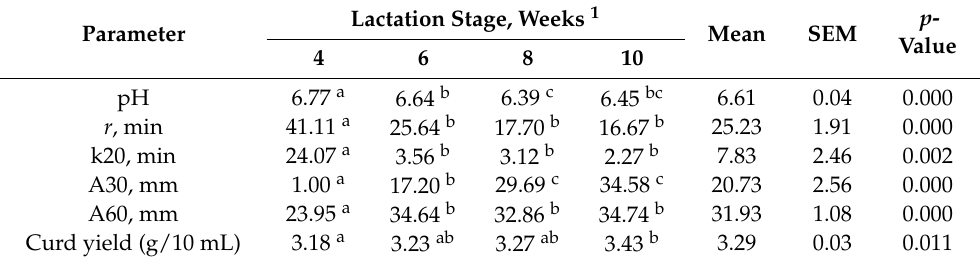
Table 6. Coagulation parameters of red deer pool milk at different lactation periods. Lactation Stage, Weeks 1 Parameter